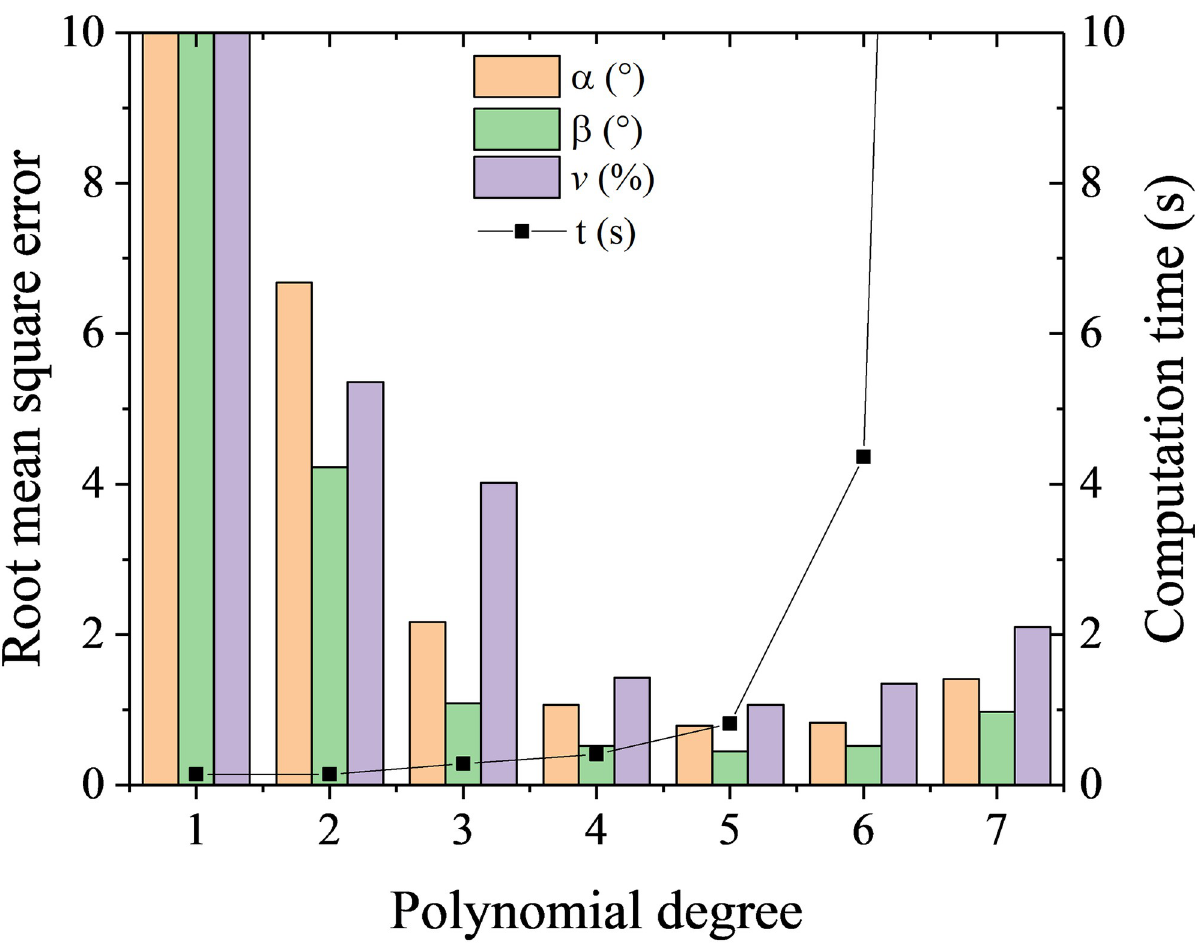
Fig 7. RMSEs and computation time at different cases with polynomial regression.